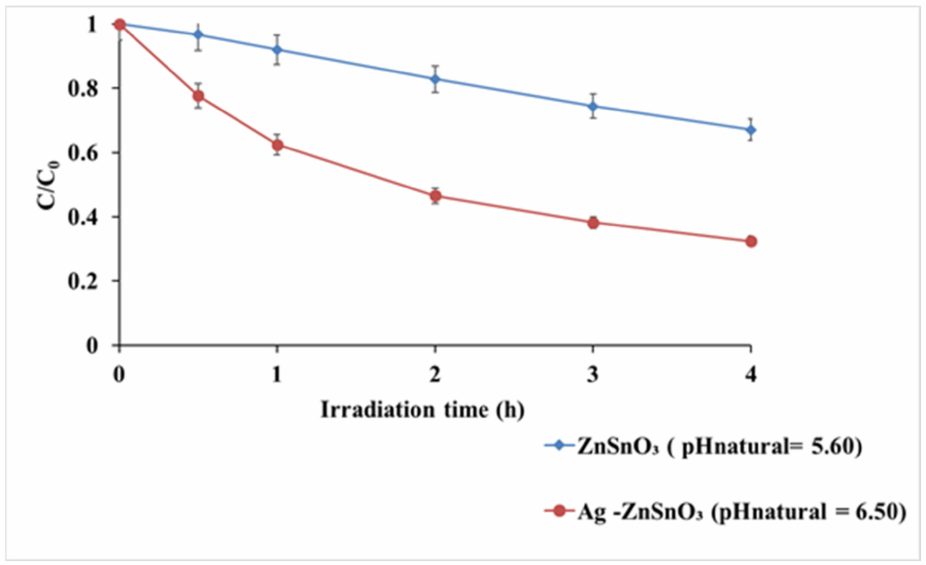
Figure 8. Degradation of 10 mg/L caffeine by 1 g/L ZnSnO 3 (blue line) at pH natural = 5.60, and 1 g/L Ag-ZnSnO 3 (red line) at pH natural =